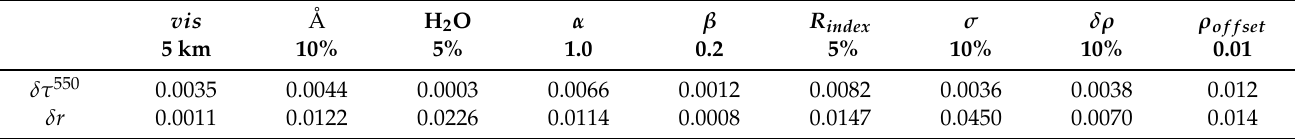
Table 2. AOT and modal radius uncertainties corresponding to the uncertainties on the background aerosol model with the visibility vis and Ångström coefficient, the water vapor, the plume geometry α and β , the real part of the refractive index R index , the standard deviation of the plume aerosol size distribution, the surface reflectance relative error δρ , and the surface reflectance